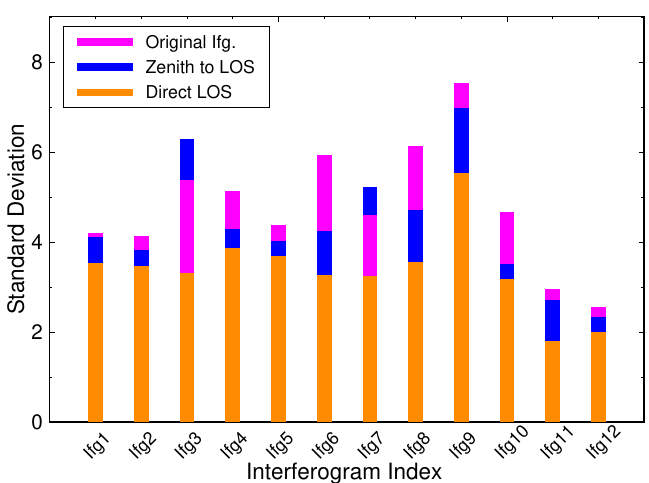
Figure 14. SD comparison of original interferograms (magenta bars), residual phases corrected from the Z-LOS method (blue bars), and residual phases after D-LOS correction (orange bars) on all twelve pairs in